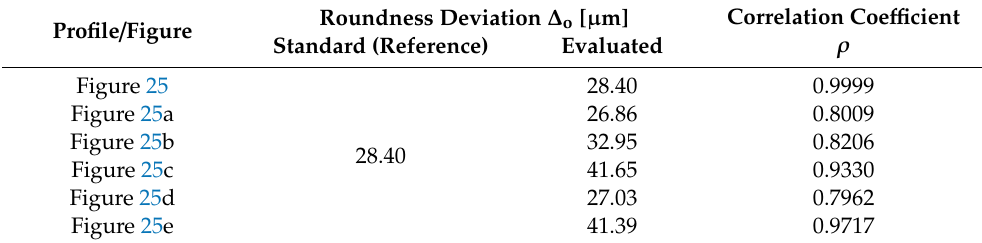
Table 11. Roundness deviations ∆ o for the profiles compared in Figures 21 and 22. The correlation coe ffi cients ρ between the compared profiles. Roundness Deviation ∆ o [ µ m] Correlation Coe ffi cient Profile / Figure